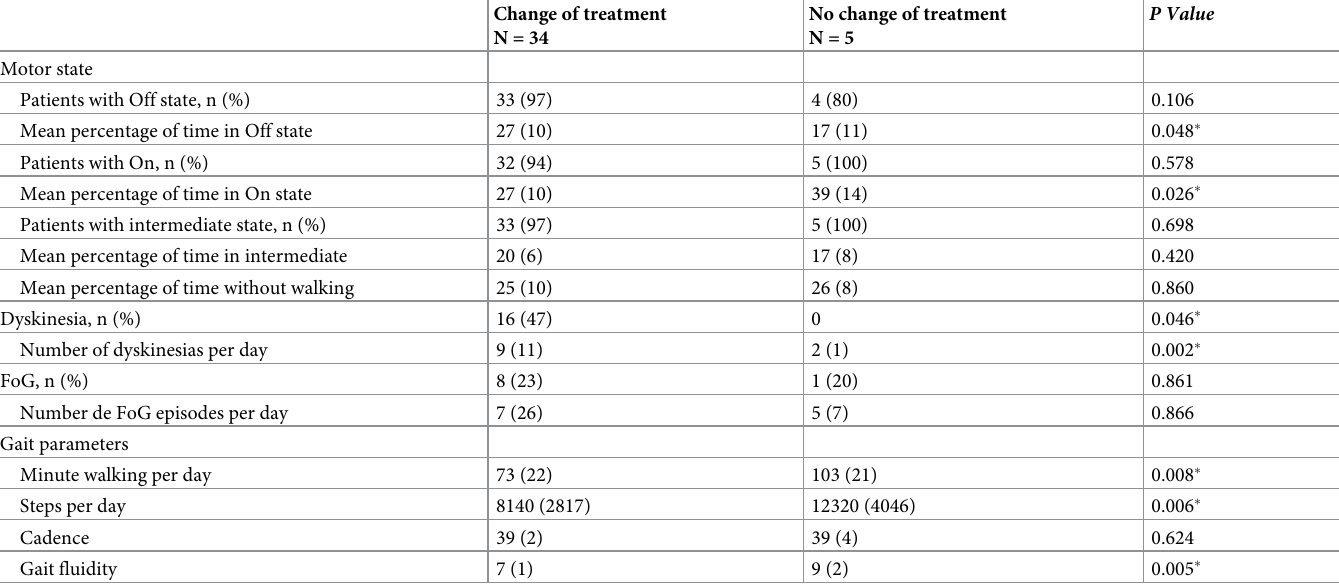
Table 2. Characteristics of the motor state, the motor complications, FoG, and gait parameters of the patients detected by the Wearable Inertial Sensor at baseline.